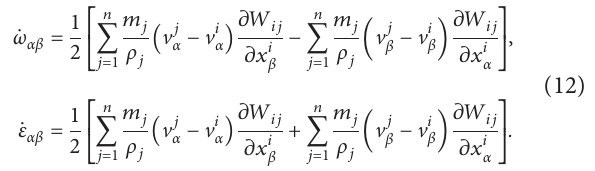
Figure 2: Axisymmetric collapse of a cylindrical sand body: the yellow region denotes initial sand column, and the dashed curve denotes final configuration (drawn according to reference